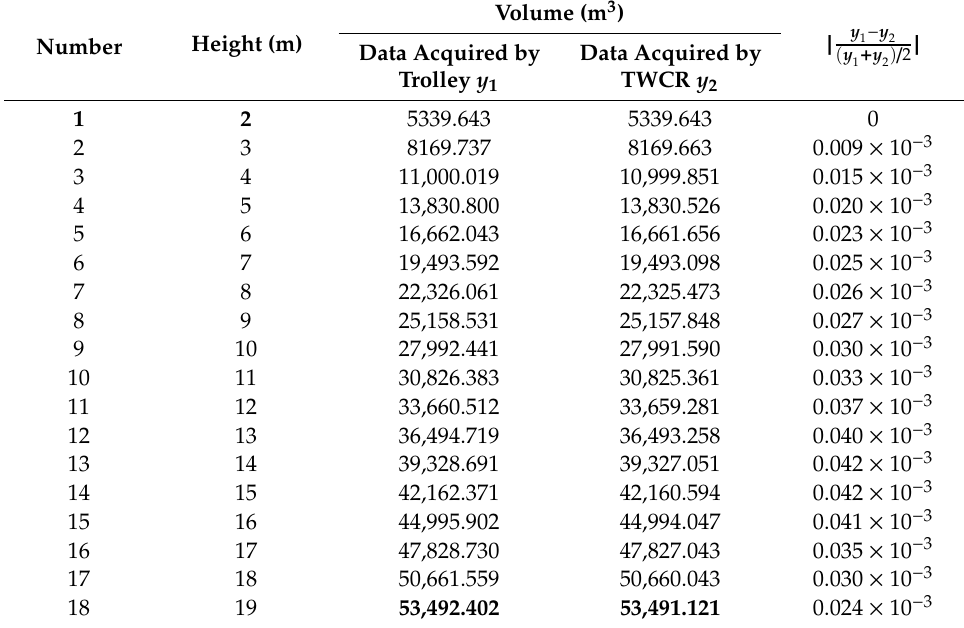
Table 7. Volume data